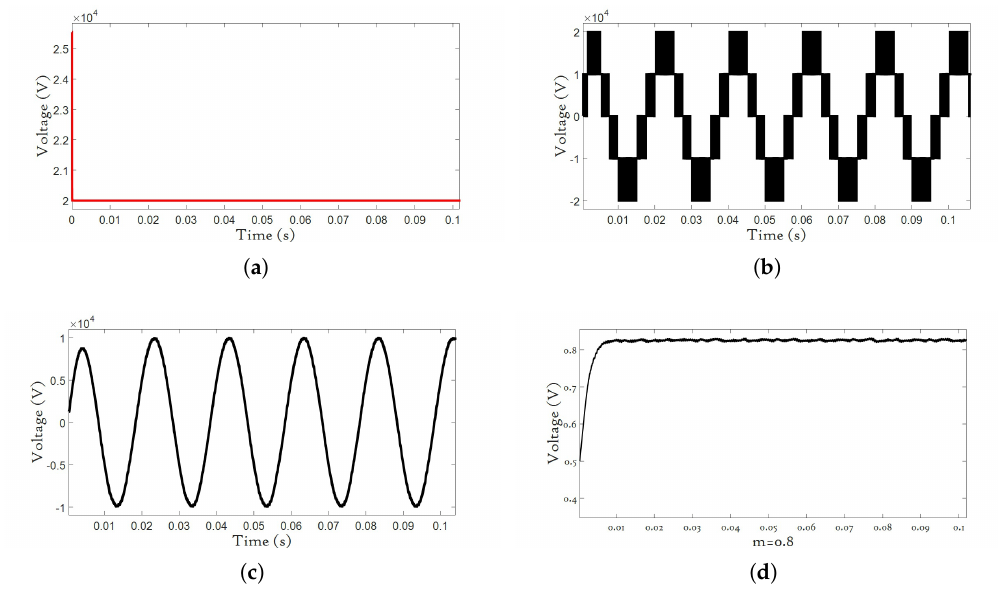
Figure 10. HV side: ( a ) Input DC voltage, ( b ) line voltage, ( c ) output AC and ( d ) modulation index